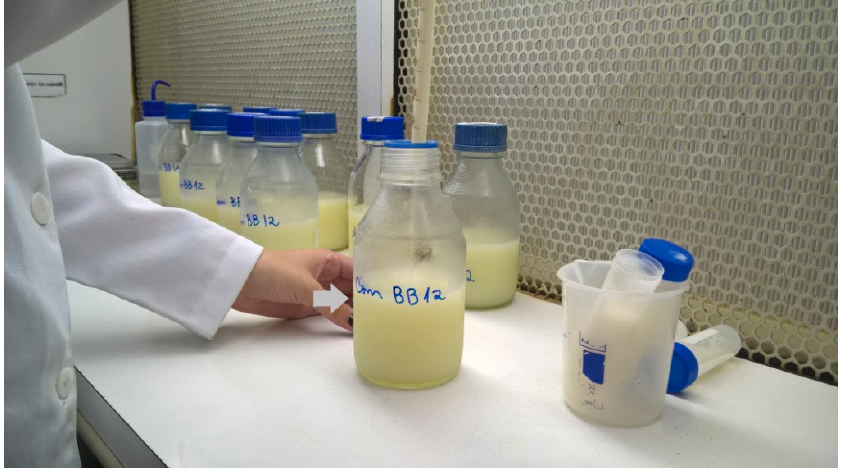
Figure 2. Addition of the probiotic culture, Bifidobacterium animalis subsp. lactis Bb12, to the premix .